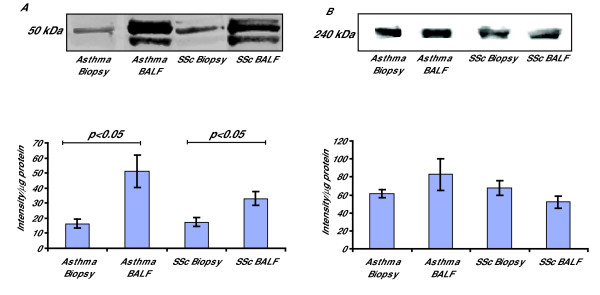
Expression of fibronectin isoforms in fibroblasts from BALF and bronchial biopsies from patients with mild asthma and SSc. Fibroblasts were cultured from bronchial biopsies and BALF from patients with SSc and mild asthma and harvested in lysis buffer as described in the Method section. Equal amounts of protein were loaded on 4–12% Bis-Tris gels. The production of the alternatively spliced isoform ED-A fibronectin (A) and cellular fibronectin (B) was measured using Western Blot with human ED-A fibronectin and cellular fibronectin antibodies. Quantification of fibronectin expression was performed by measuring the optical density of the bands. Values are presented as means ± SEM for n = 5 patients/group.